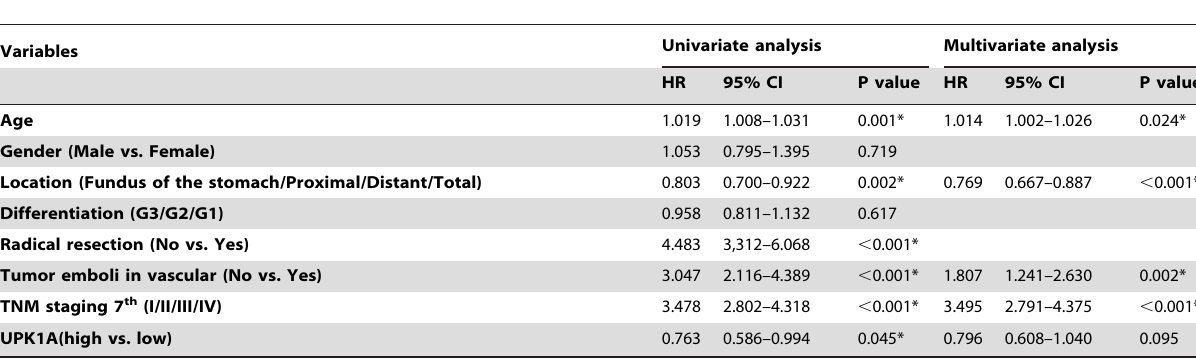
Table 2. Univariate and multivariate analyses of overall survival in 445 cases of gastric cancer patients.